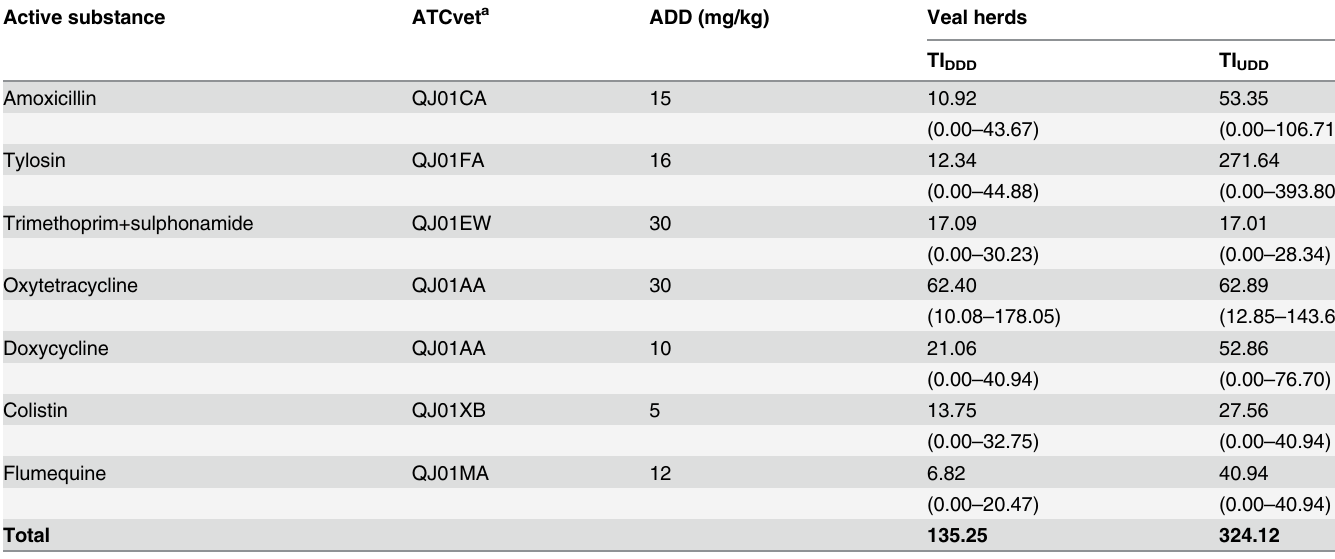
Table 4. Average treatment incidences (min-max) based on the animal defined daily dose (ADD; TI ADD ) and the prescribed daily dose (UDD; TI UDD ) of the orally administered antimicrobial drugs in the veal herds (entire study period). Active